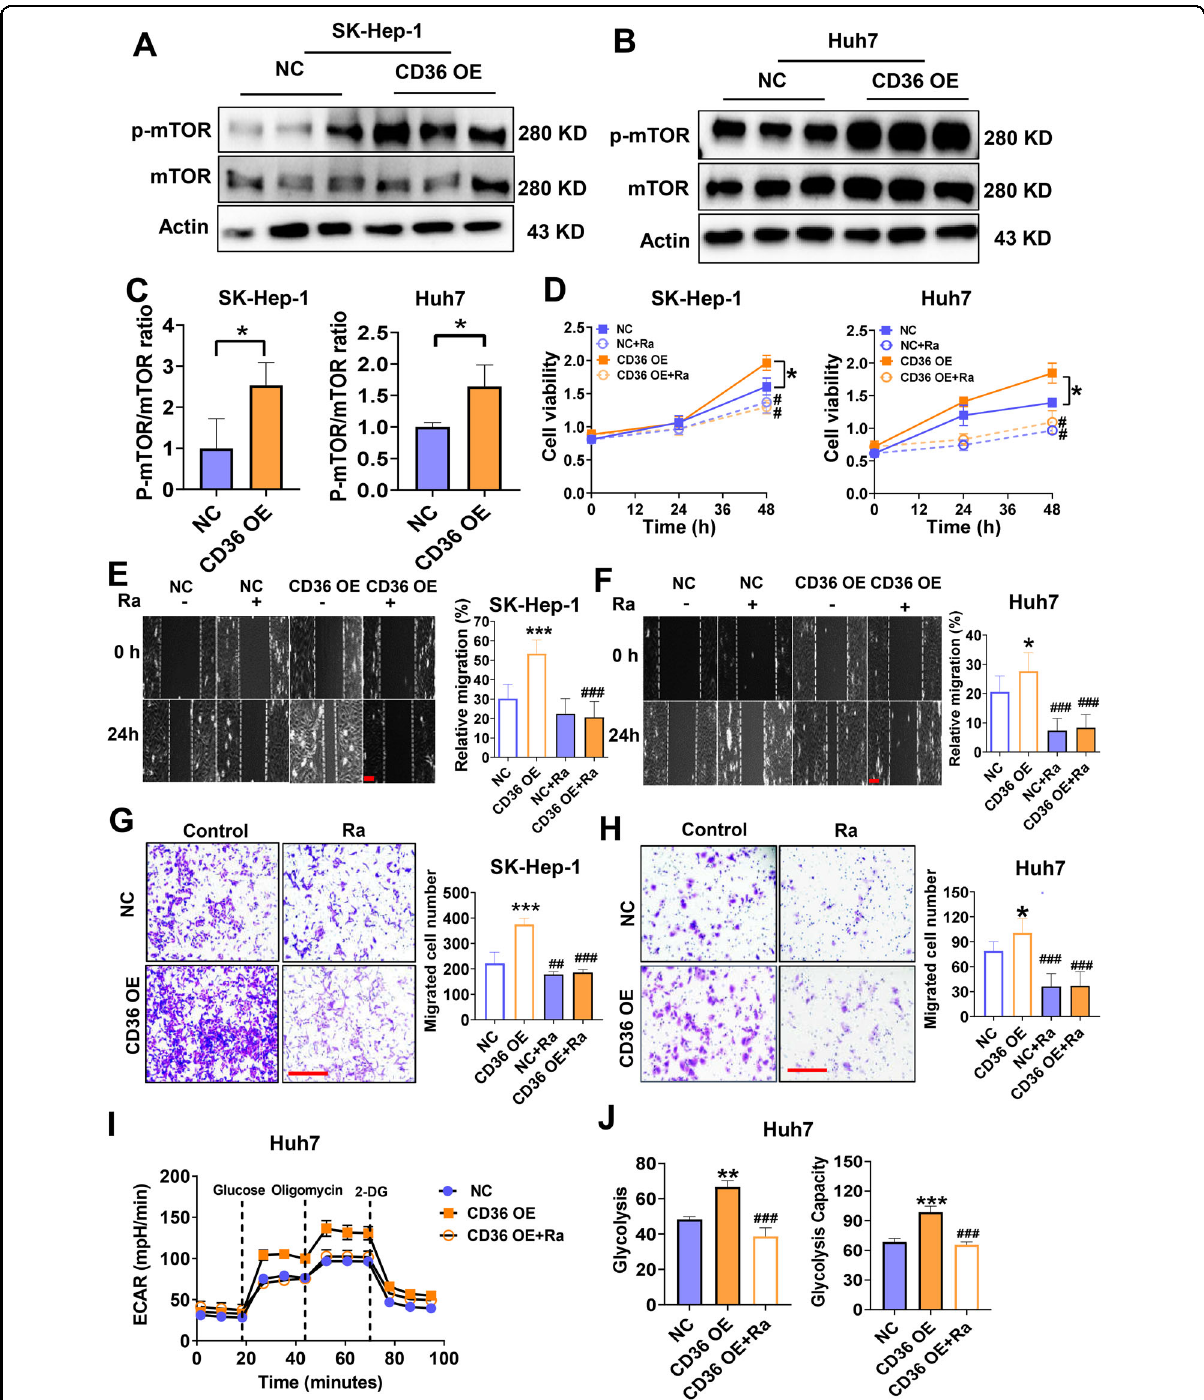
Fig. 6 CD36 regulates glycolysis by mTOR pathway. Western blot analysis of mTOR and p-mTOR expression both in SK-Hep-1 ( A ) and Huh7 cells ( B ) ( n = 3). C The histogram represented the densitometric scans for protein bands from A and B . D Proliferation of HCC cells treated with or without rapamycin (RA, 8 μ M), an inhibitor of mTOR (n = 6). Wound-healing ( E , F ) and transwell assays ( G , H ) were used to evaluate the migration of HCC cells with or without RA ( n = 10). I , J Glycolytic capacity of Huh7 cells with or without RA was measured by glycolytic stress test. All data are presented as mean ± SD. * P < 0.05, ** p < 0.01, and *** p < 0.001 compared with the NC group, ## P < 0.01 and ### p < 0.001 compared with the group without RA. Bar = 100 μ m ( E – H ). P -value was calculated using Student ’ s t -test ( C ) and one-way analysis of variance with Tukey ’ s multiple comparison tests ( D – J